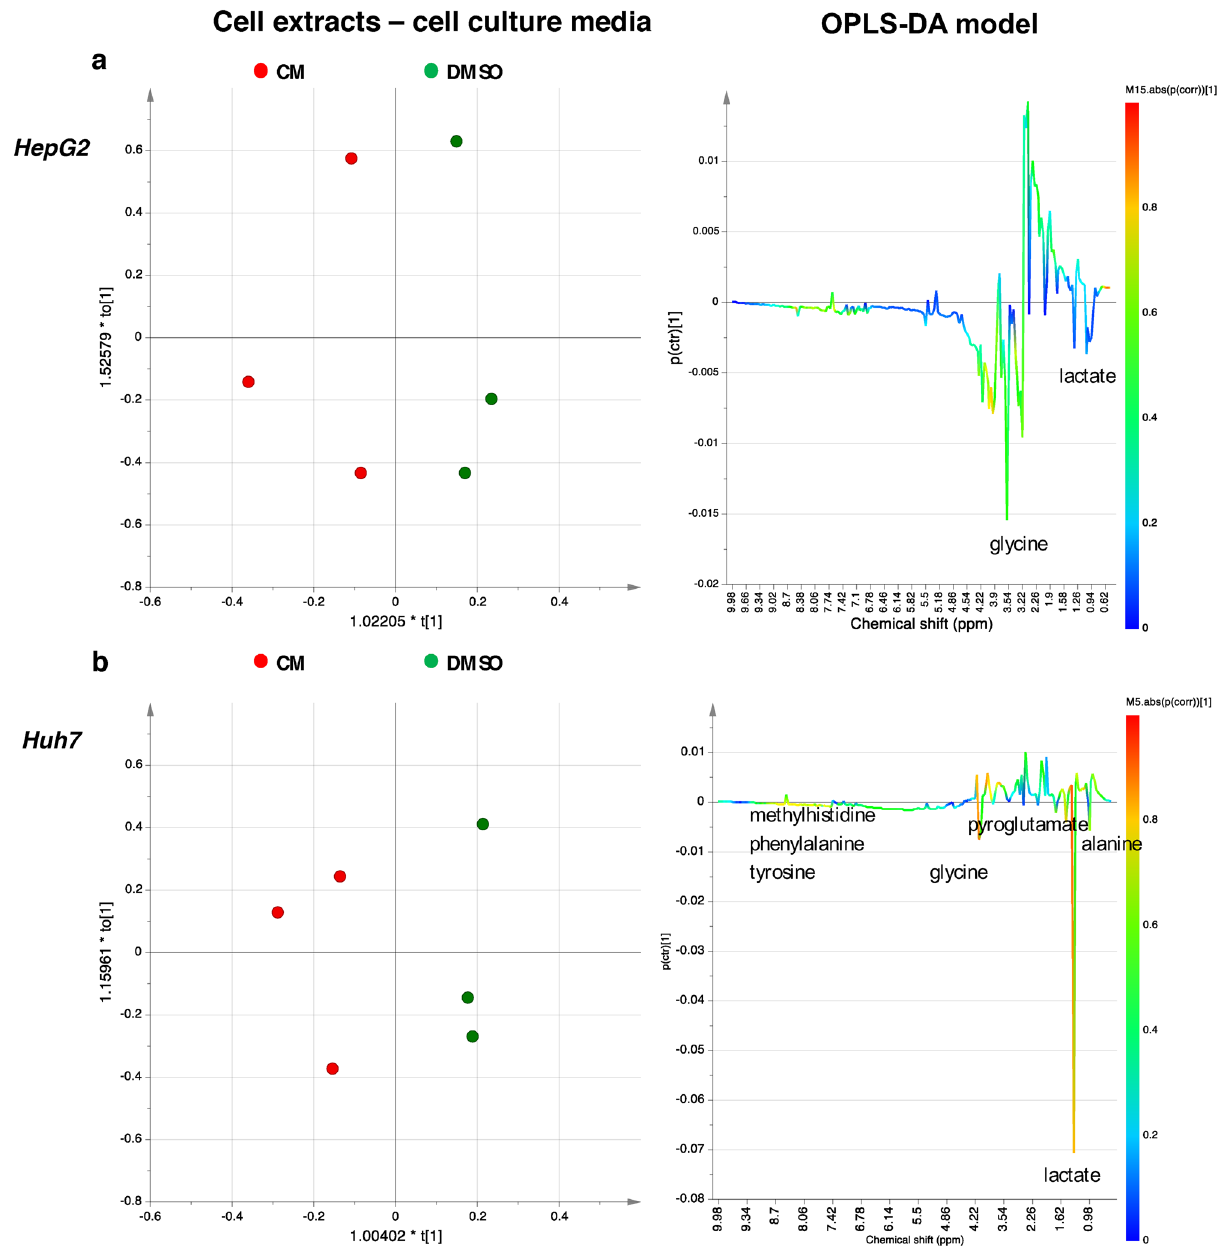
groups. DMSO Vehicle treatment, CM Crithmum maritimum